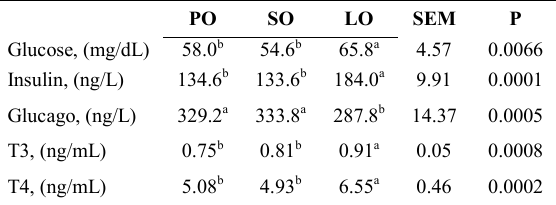
Table 4. The effects of palmitic, linoleic, and α- linolenic acid diets on blood glucose and hormones level in finishing